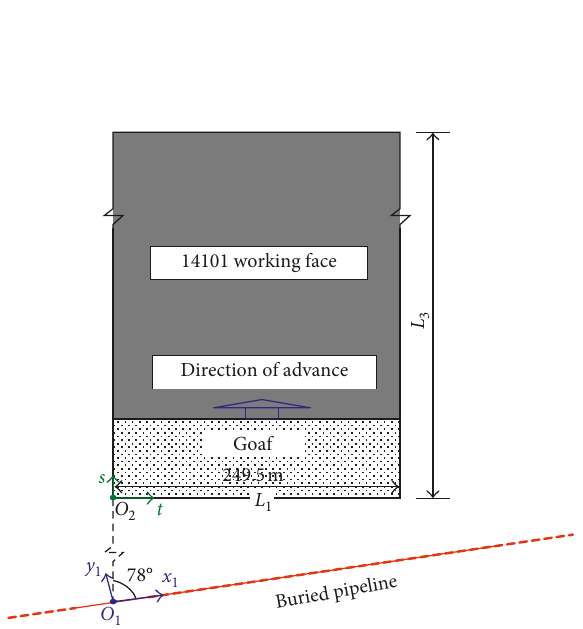
Figure 9: Locations of 14101 working face and buried pipeline through plane